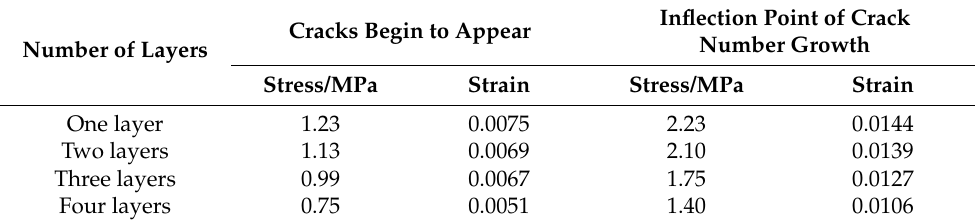
Table 8. The relationship between stress – strain and crack increments.